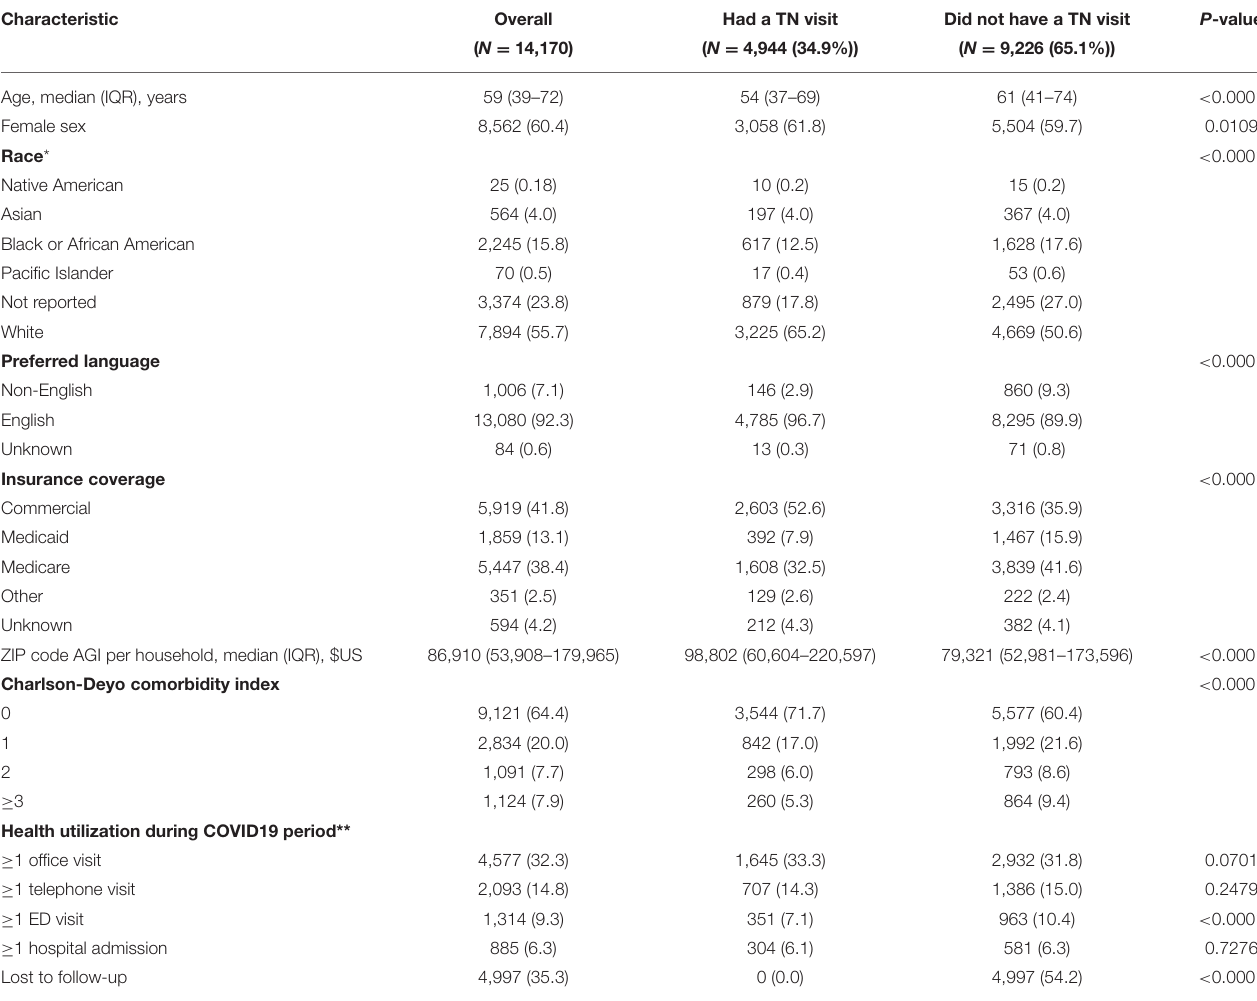
TABLE 1 | Patient characteristics, stratified by teleneurology utilization during the COVID period. Characteristic